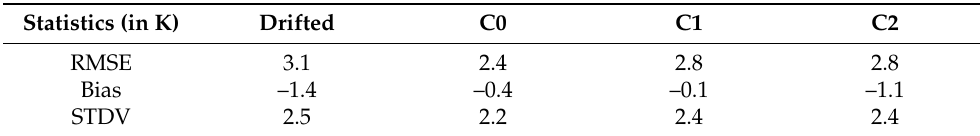
Table 3. Overall statistics for all selected BELMANIP sites and all NOAA platforms between drift-ed and reference time series as well as for each orbital drift correction method (C0, C1, and C2). STDV stands for standard deviation.